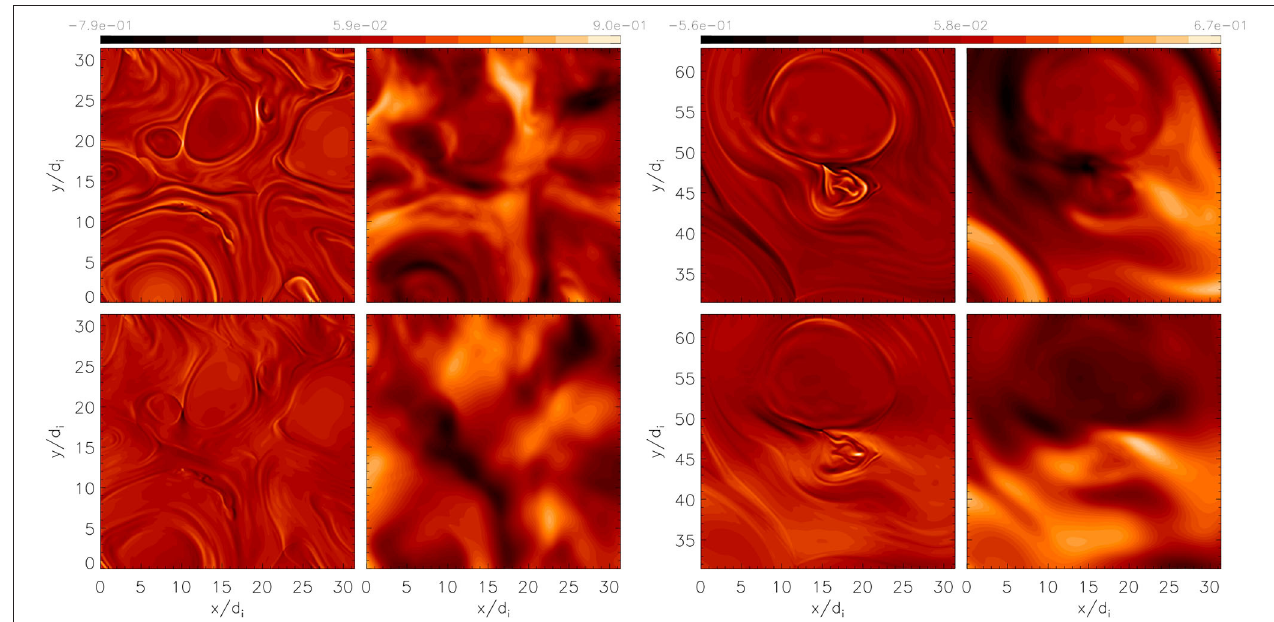
u e, z J z / n (top left); the out-of-plane ion flow, u i, z (top right); and the − ≈